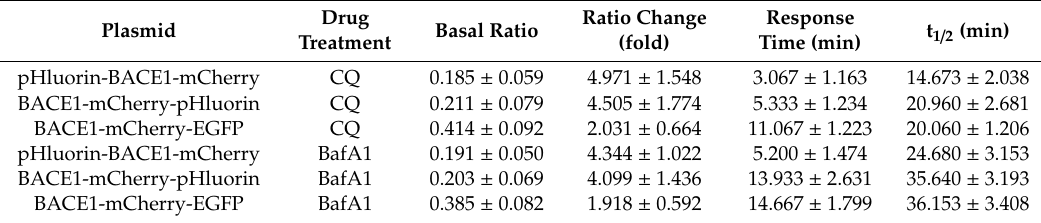
Table 1. Summary of BACE1 plasmids in response to CQ and BafA1 in NLT cells. Drug Plasmid Basal Ratio Treatment